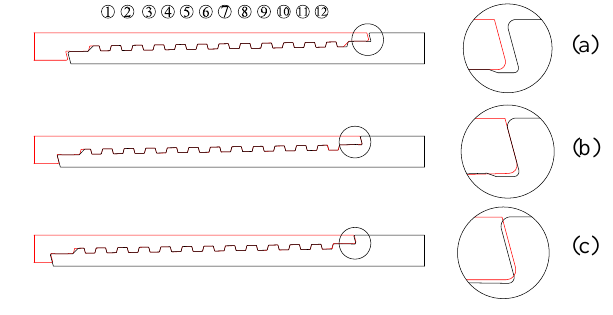
Figure 6. Connection states of the